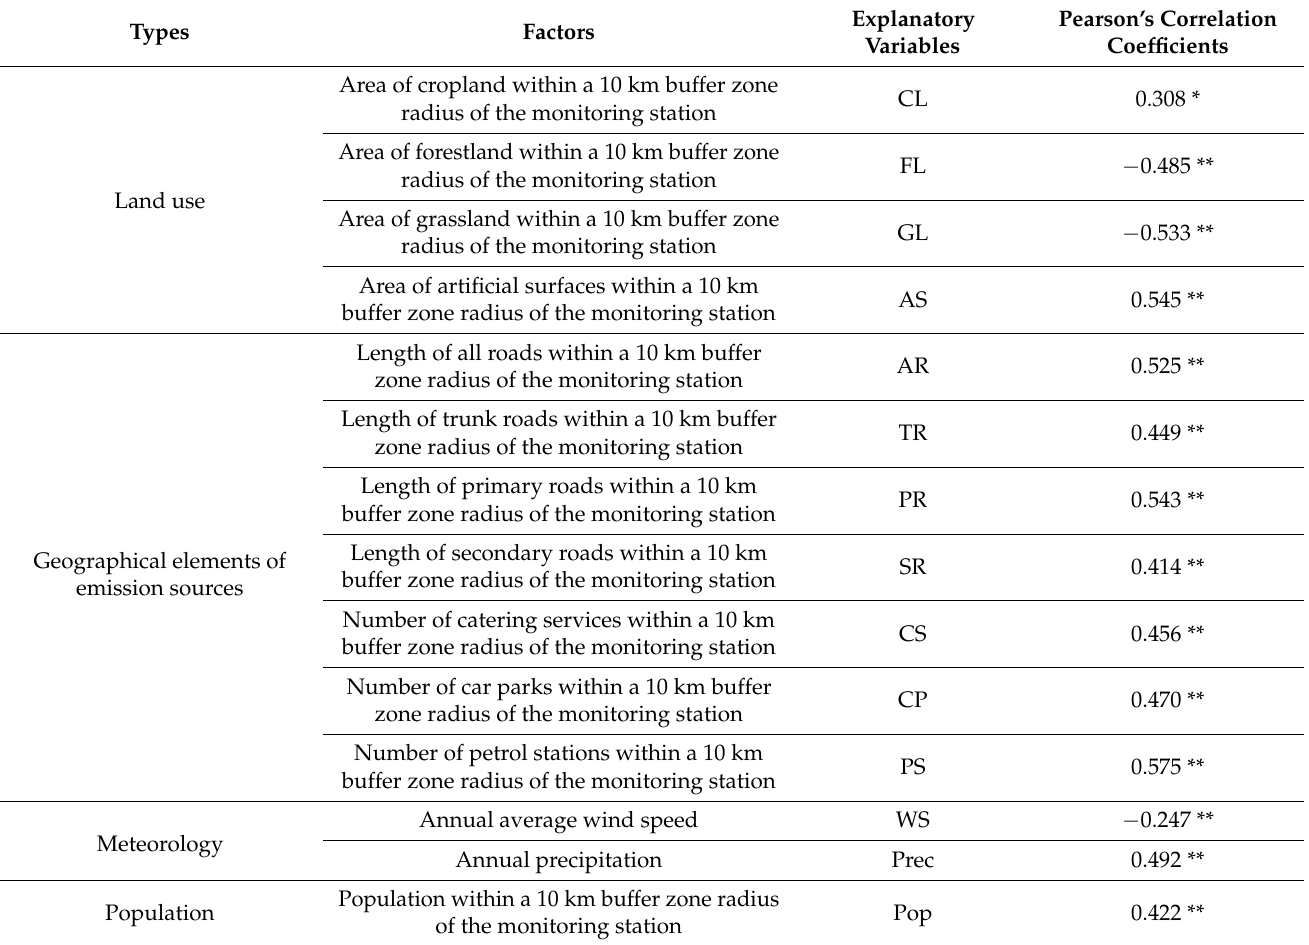
Table 1. Correlation analysis